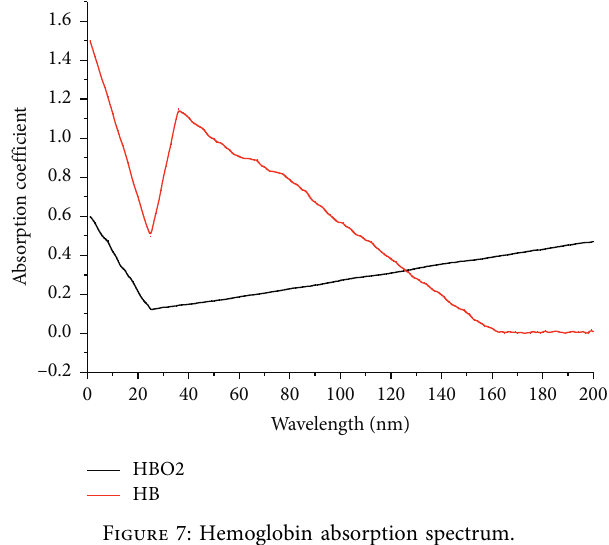
Figure 7: Hemoglobin absorption spectrum.